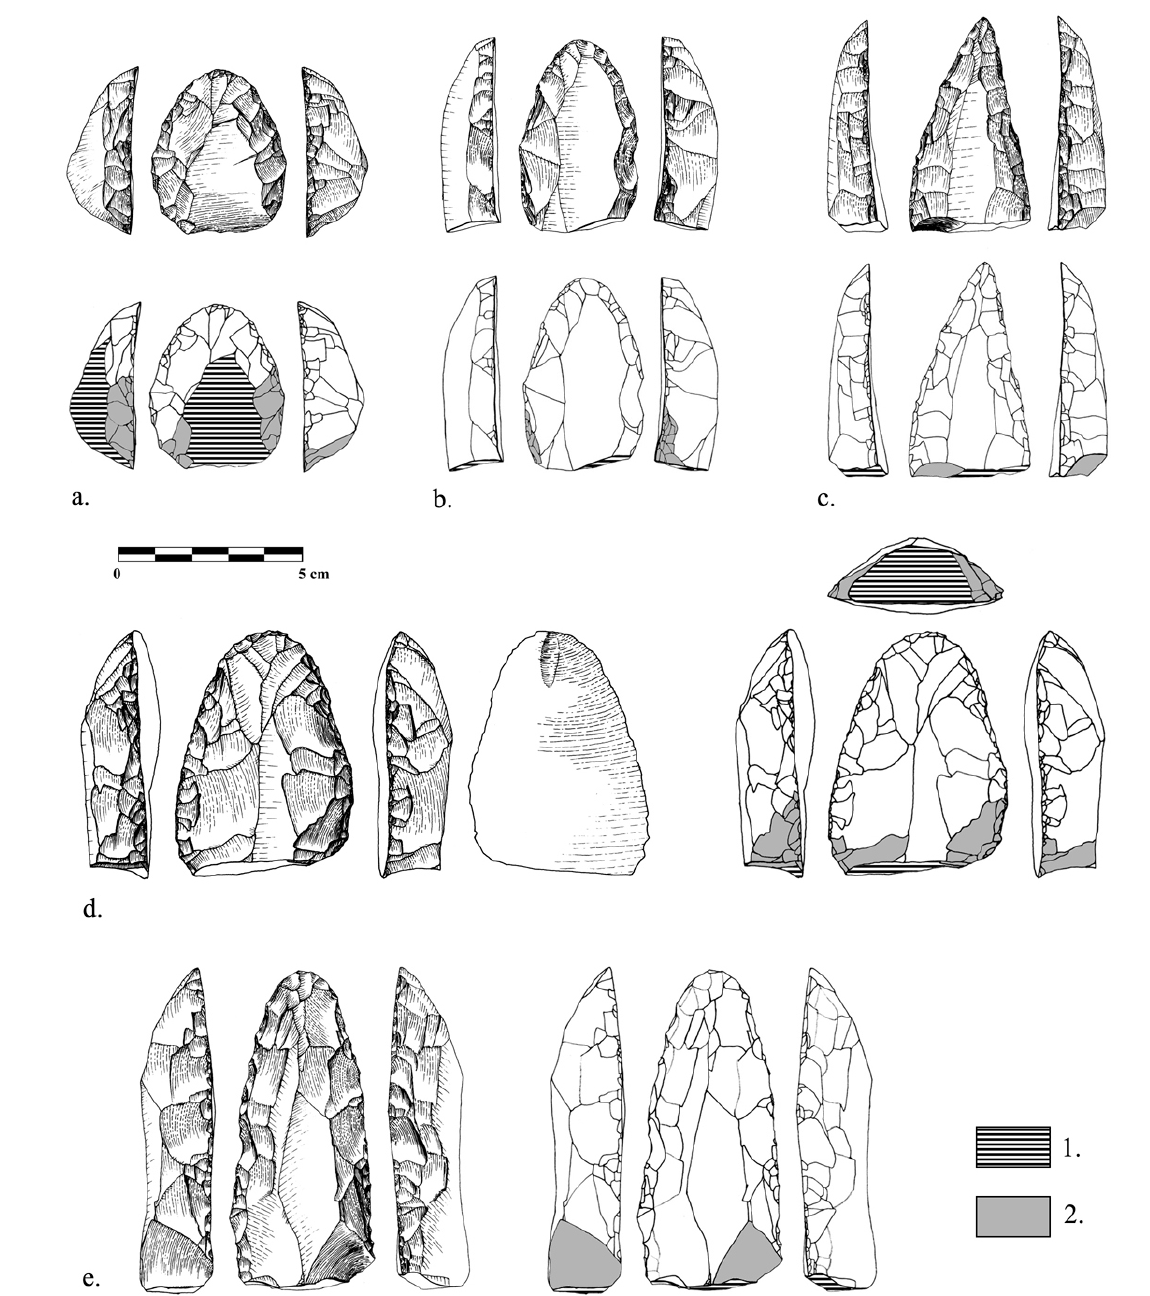
Figure 8. Pièces façonnées unifacialement reprises après fracture. Légende des schémas : 1 : surface de fracture, 2 : négatif d’enlèvement postérieur à la fracture. Figure 8. Unifacially shaped artefacts resumed after breaking. Captions: 1: breaking surface, 2: removal after